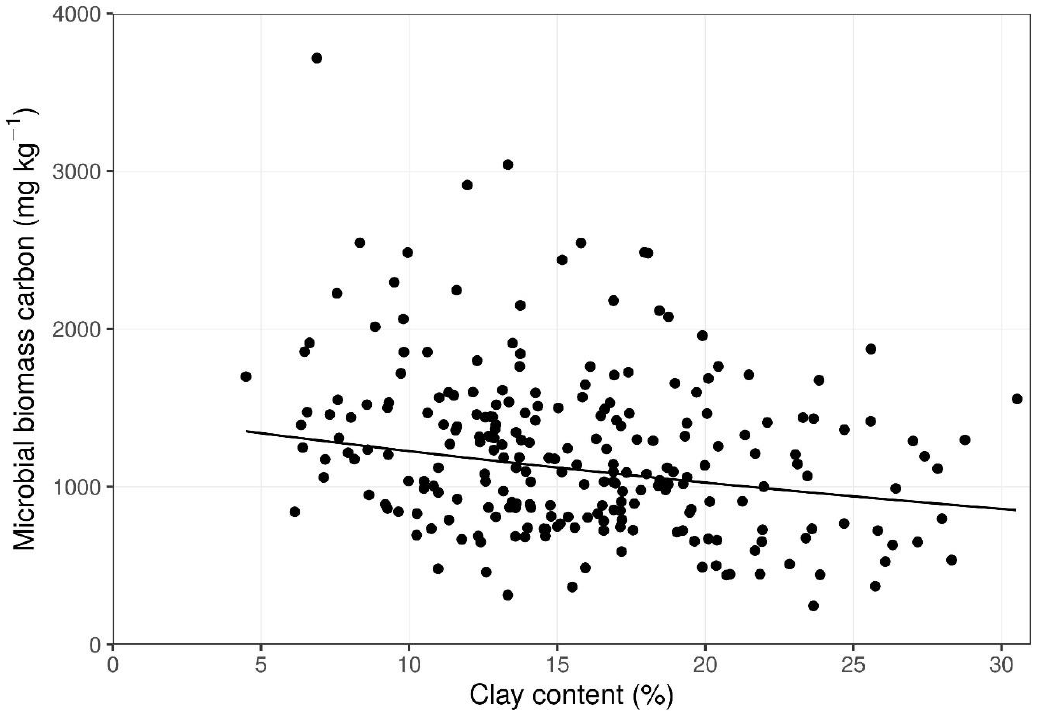
Figure 3. Response of microbial biomass carbon to soil organic carbon. See Table 2 for additional information.